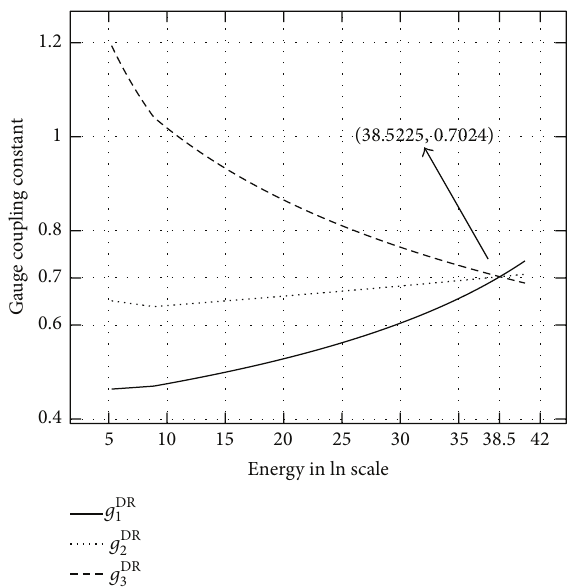
Figure 4: Gauge couplings unification for 𝑚 𝑠 = 7 TeV, (𝑒 38 . 5225 = 5 . 3722 × 10 16 ) GeV.